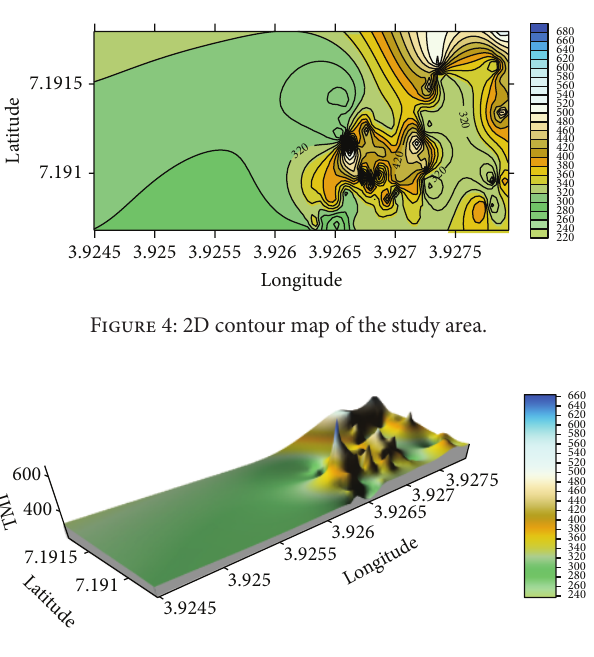
Figure 5: 3D contour map of the study area.